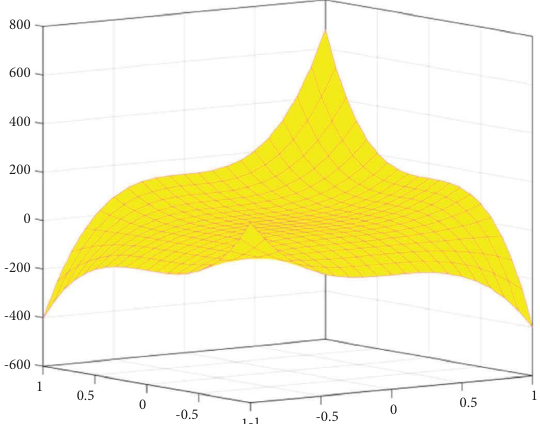
Figure 4: Te correlation of r and M